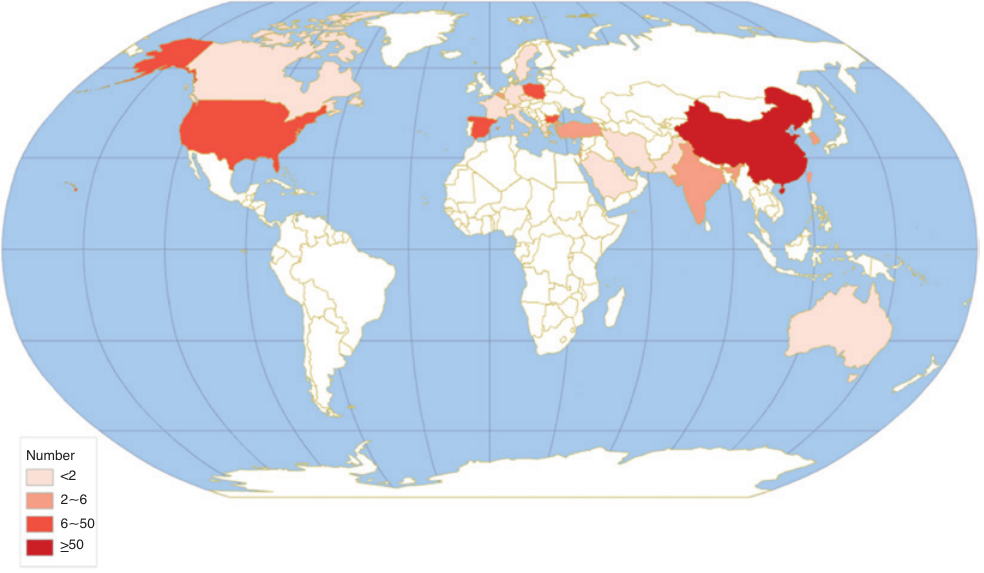
Figure 1: Global Geographic Distribution of the Highly Cited Publications in IFS.